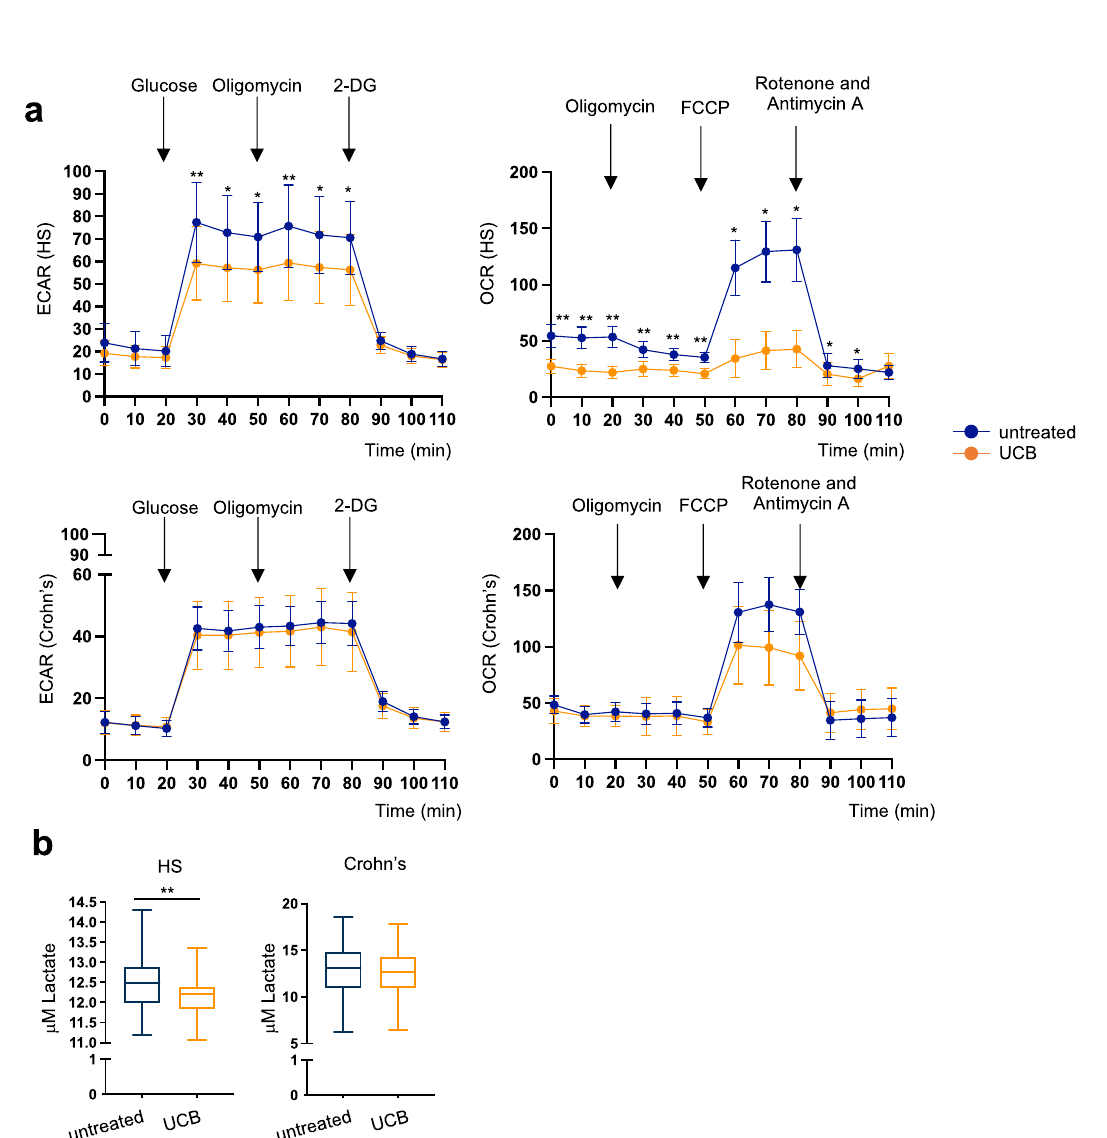
Fig. 2 Unconjugated bilirubin limits Th17 cell glycolysis rate. Extracellular acidi fi cation rate (ECAR) and oxygen consumption rate (OCR) of Th17 cells in the absence or presence of UCB was determined by Seahorse. a Mean± SEM ECAR and OCR measured by Seahorse in untreated and UCB treated Th17 cells of HS ( n = 9 for ECAR and n = 10 for OCR) and Crohn ’ s disease patients ( n = 7). UCB effectively reduces ECAR and OCR in Th17 cells of HS, this effect being less marked in Th17 cells obtained from patients with Crohn ’ s disease. b Box-and-whisker plots representing lactate levels in the culture supernatants of untreated and UCB treated Th17 cells from HS ( n = 10) and patients with Crohn ’ s disease ( n = 10). * P ≤ 0.05 and ** P ≤ 0.01 using two- sided unpaired t